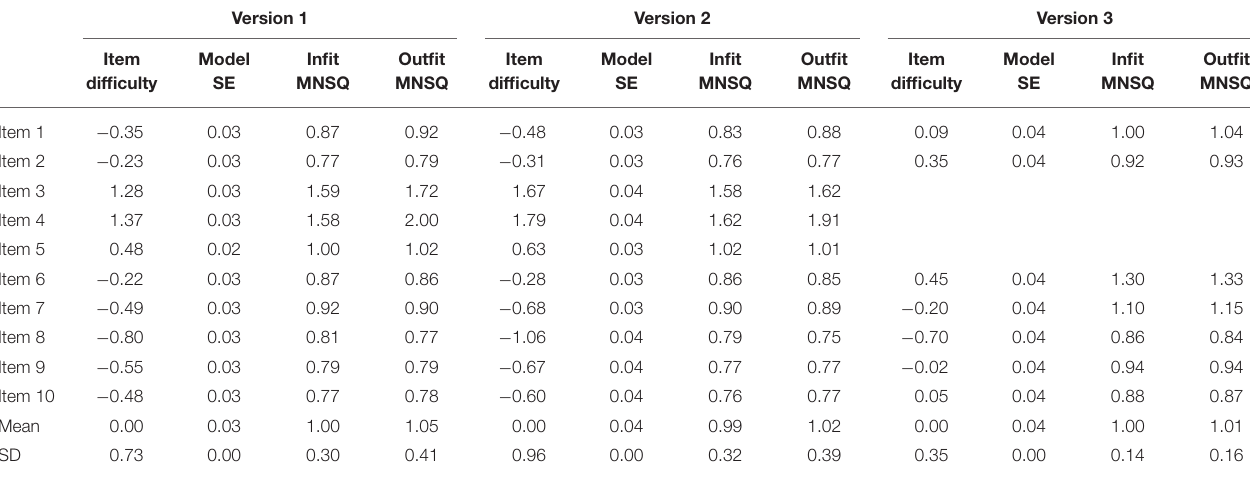
TABLE 3 | Item difficulty and item fit statistics for KIDSCREEN before and after merged response categories 2 and